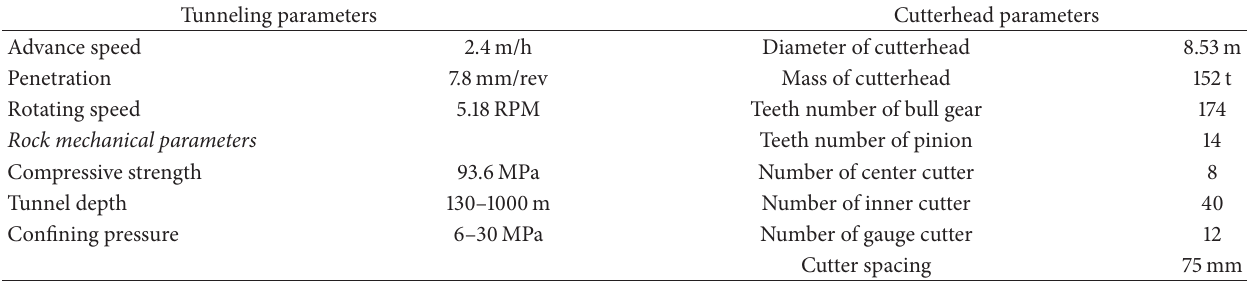
Table 1: The tunneling parameters and cutterhead